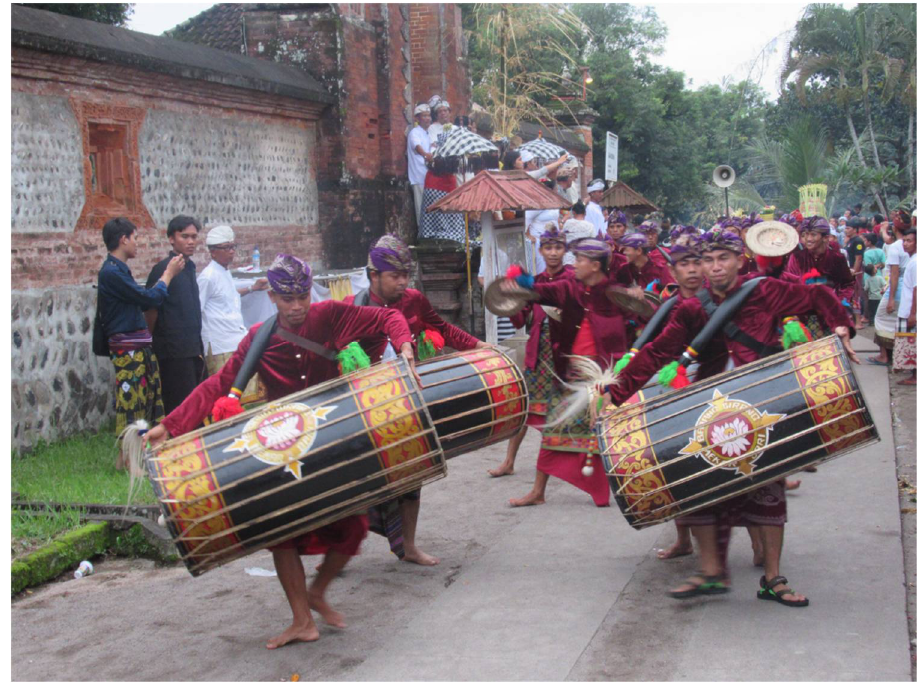
Figure 2. A circumambulating Sasak gendang beleq troupe processes passed the Balinese gadoh, Lingar, 2017. Photo by author.